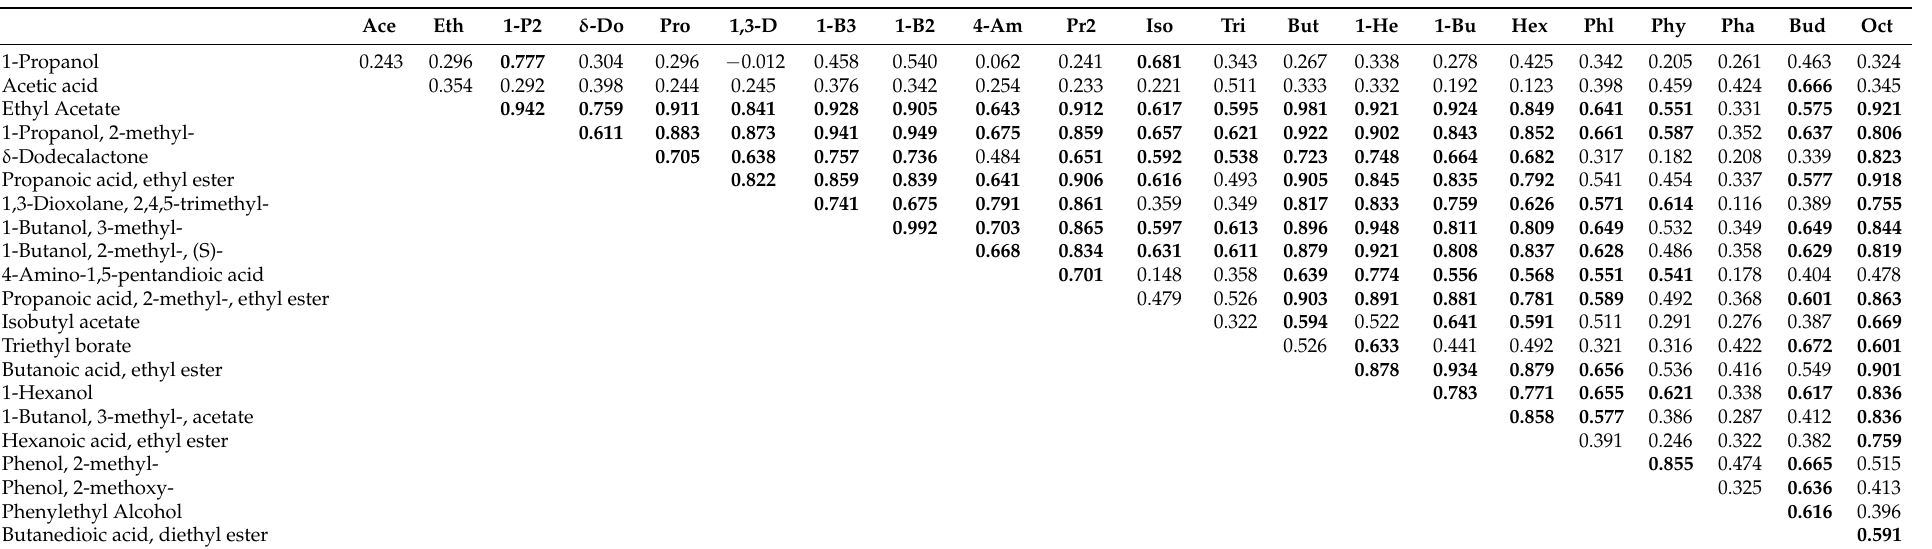
Table 12. Pearson correlation coefficients ( r ) amongst twenty-one volatile organic compounds (VOCs) of white wine from Debrecen-Pallag, Hungary. Bold figures represent the significant ( p < 0.05) correlation coefficient values among parameter pairs. Ace: Acetic acid, Eth: Ethyl Acetate, 1-P2: 1-Propanol, 2-methyl, δ -Do: δ -Dodecalactone, Pro: Propanoic acid, ethyl ester, 1,3-D: 1,3-Dioxolane, 2,4,5-trimethyl-, 1-B3: 1-Butanol, 3-methyl-, 1-B2: 1-Butanol, 2-methyl-, (S)-,